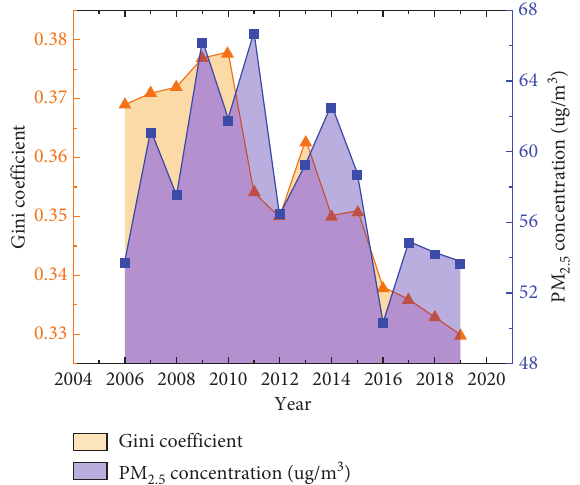
Figure 10: The Gini coefficient and the PM